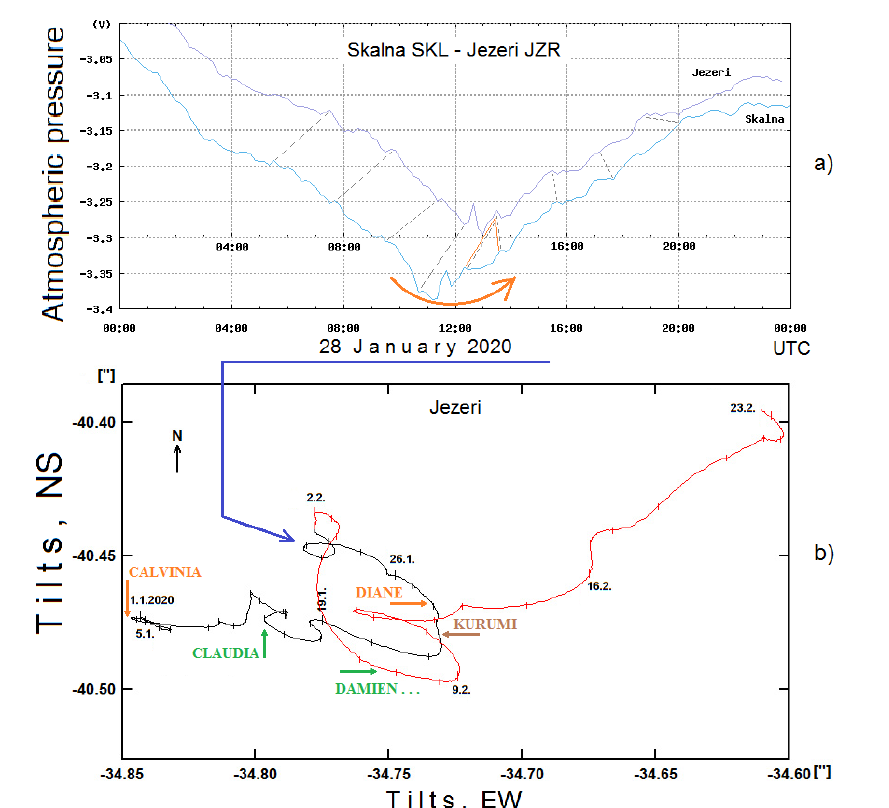
Fig. 6. Synchronous records of atmospheric pressure variations at observation points SKL and JZR on 28 January 2020 (a); vector representation of non-tidal tilts at observation point JZR during January – February 2020 together with periods of five tropical cyclones CALVINIA – DAMIEN pointed (b).